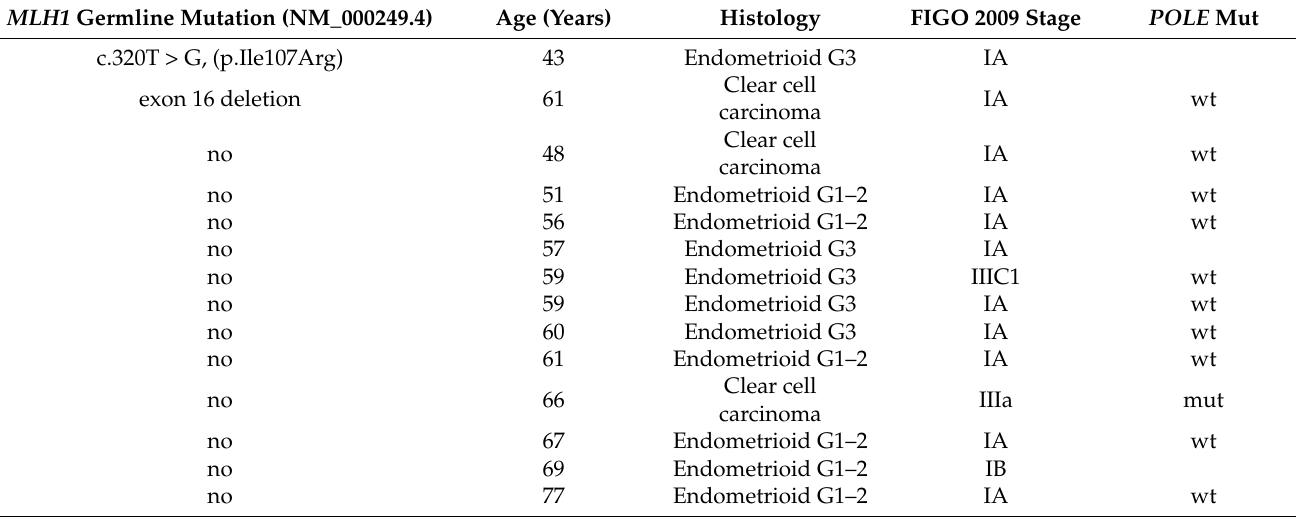
Table 2. Clinicopathological characteristics of patients with non-methylated MLH1-deficient endome- trial